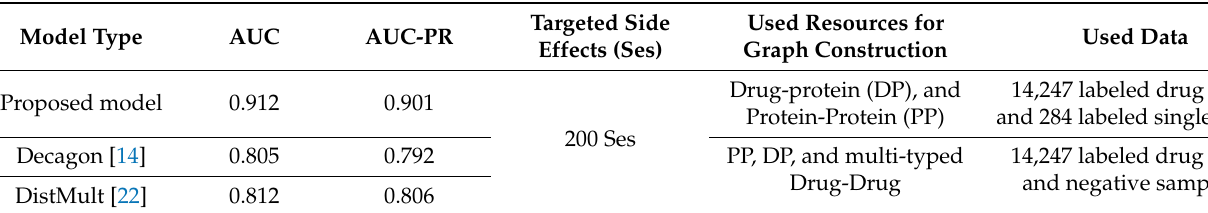
Table 5. Non-DPU side effects prediction performance comparison with existing models trained with our data.